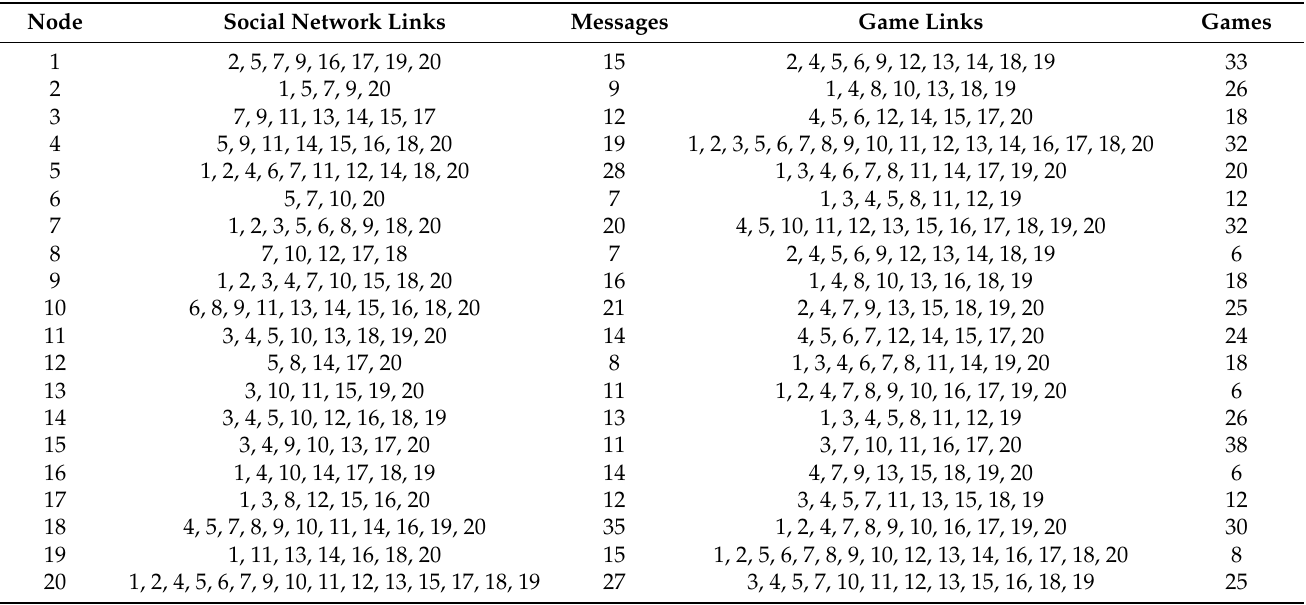
Table 3. Data associated with the biplex network constructed by the team. This table was presented in